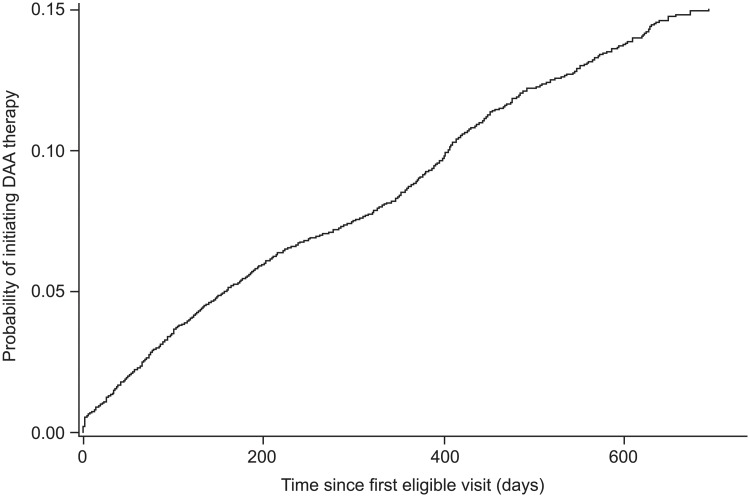
Kaplan–Meier curve: Time to treatment initiation.